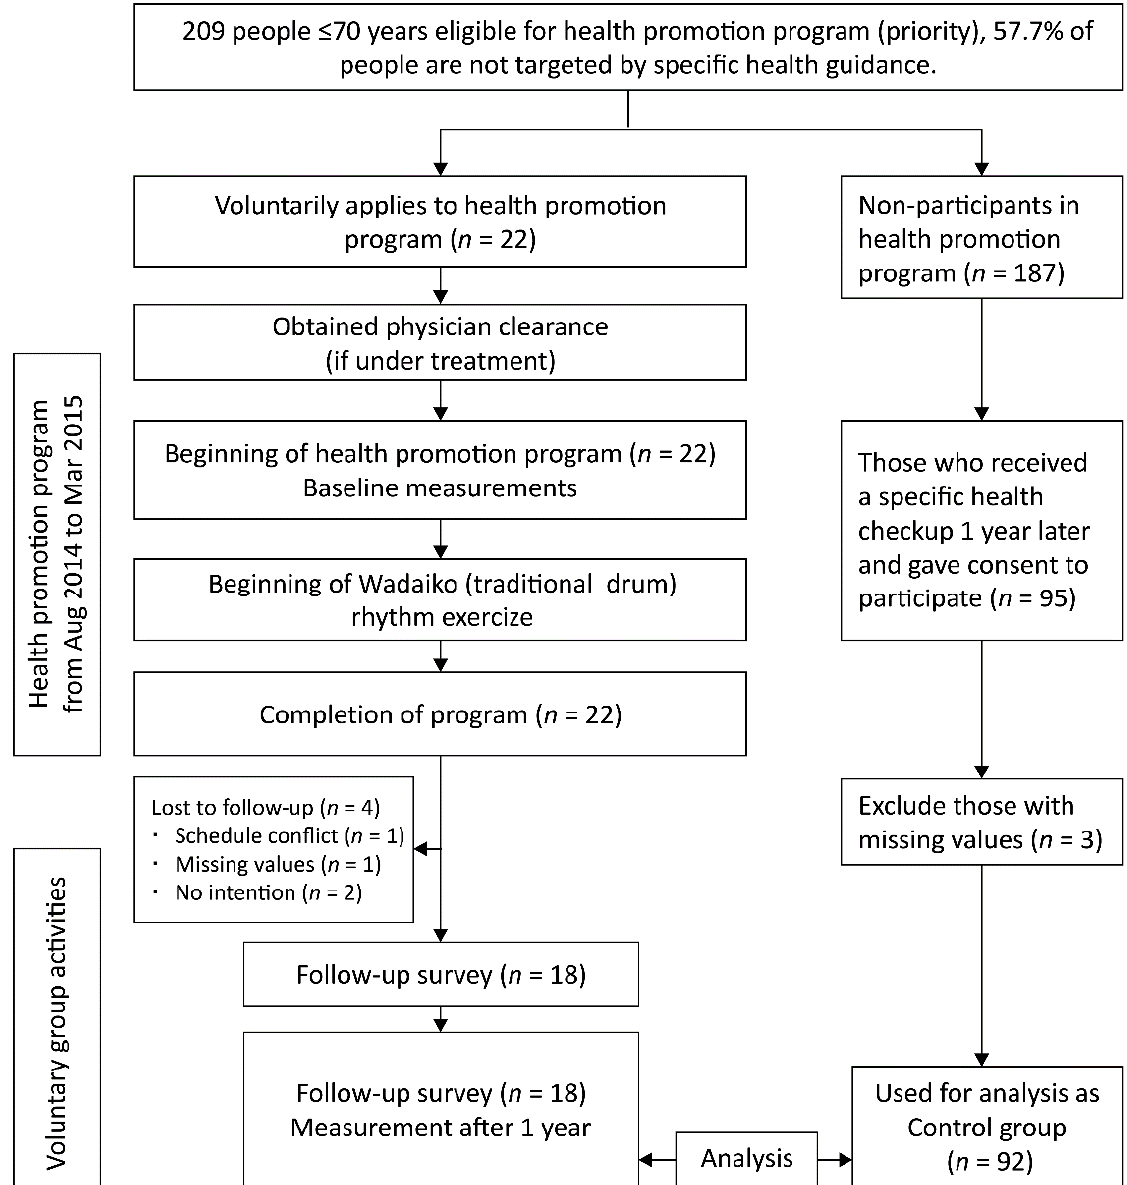
Figure 1. Study workflow diagram showing inclusion and exclusion criteria.